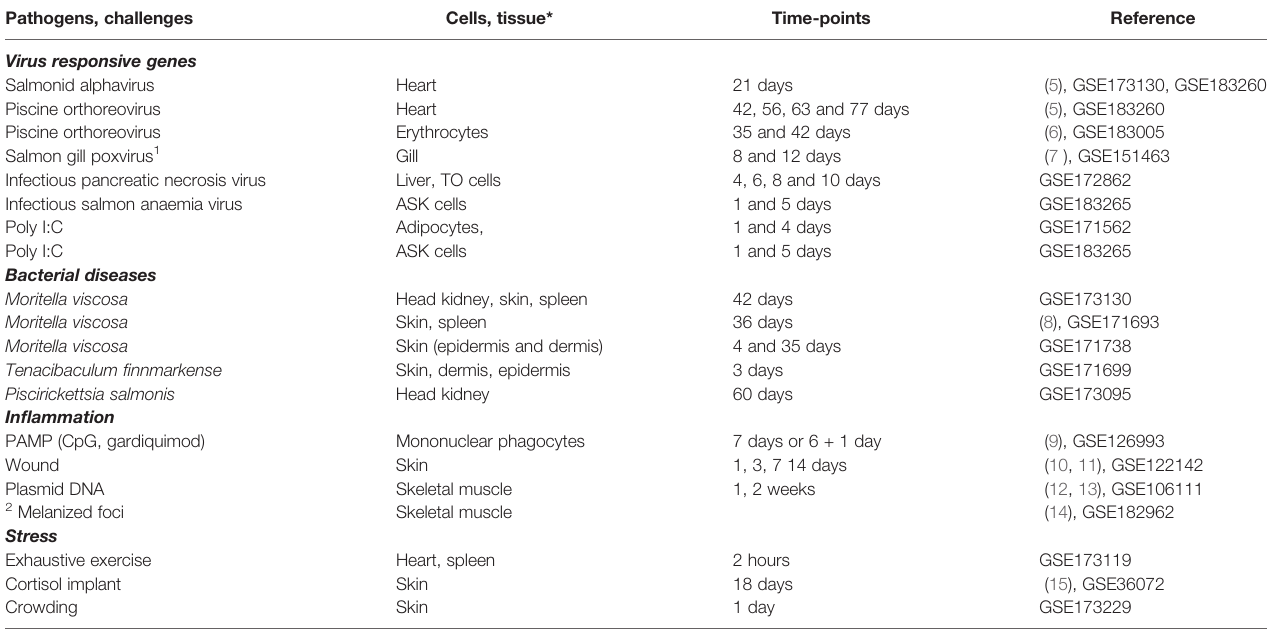
TABLE 1 | Summary of studies included in search of transcription modules (TM). Pathogens, challenges Cells,